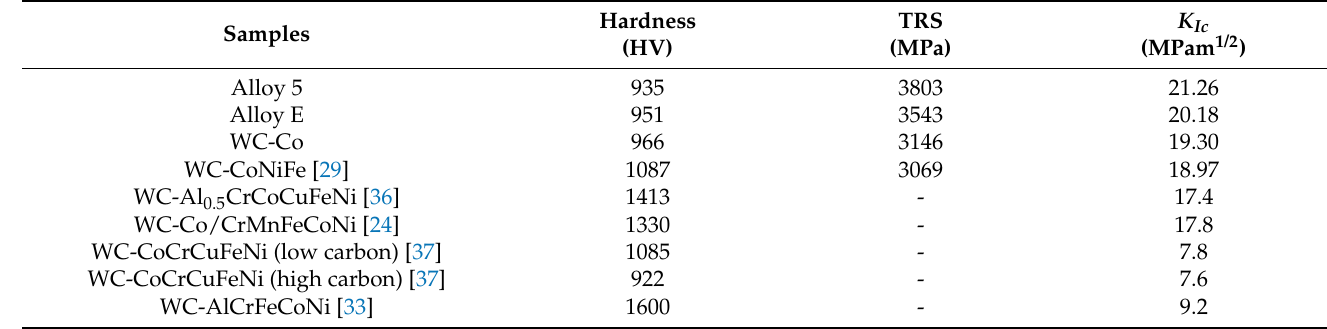
Table 4. The mechanical properties of the WC-20binder